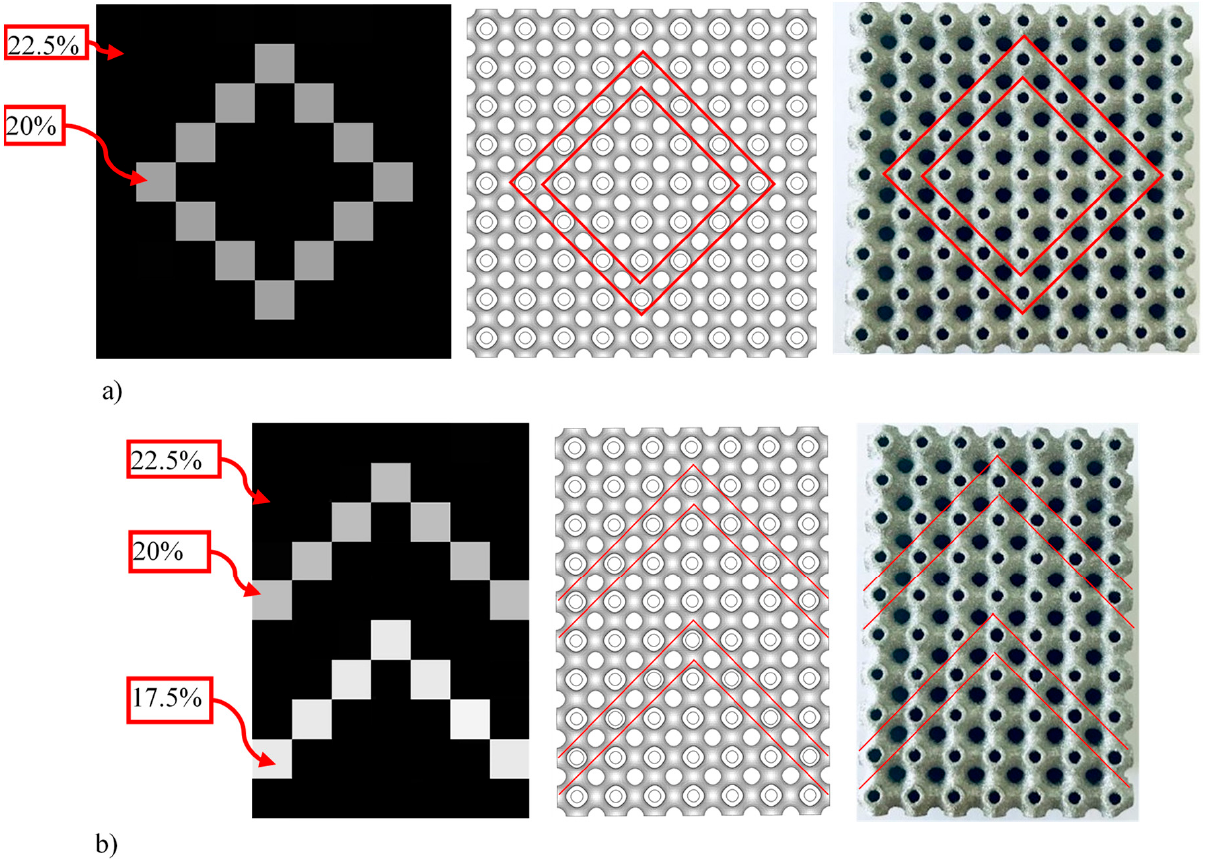
Figure 2. Grayscale image, cellular material design, and additively manufactured sample of ( a ) graded ‐ rhombic structure, and ( b ) graded ‐ arrows structure.